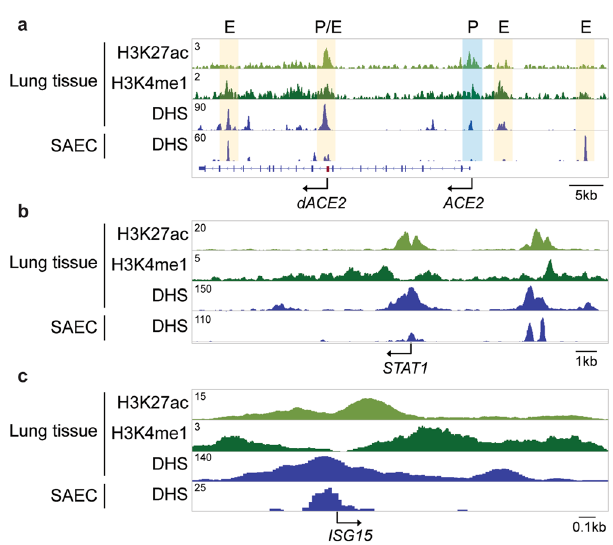
Fig. 3 Activating histone marks at the ACE2 locus in lung tissue. ChIP-seq for histone marks H3K4me1 (enhancers) and H3K27ac (active genes), and DHS from human lung tissues and DHS from SAECs display regulatory elements at the ACE2 ( a ), STAT1 ( b ), and ISG15 ( c )